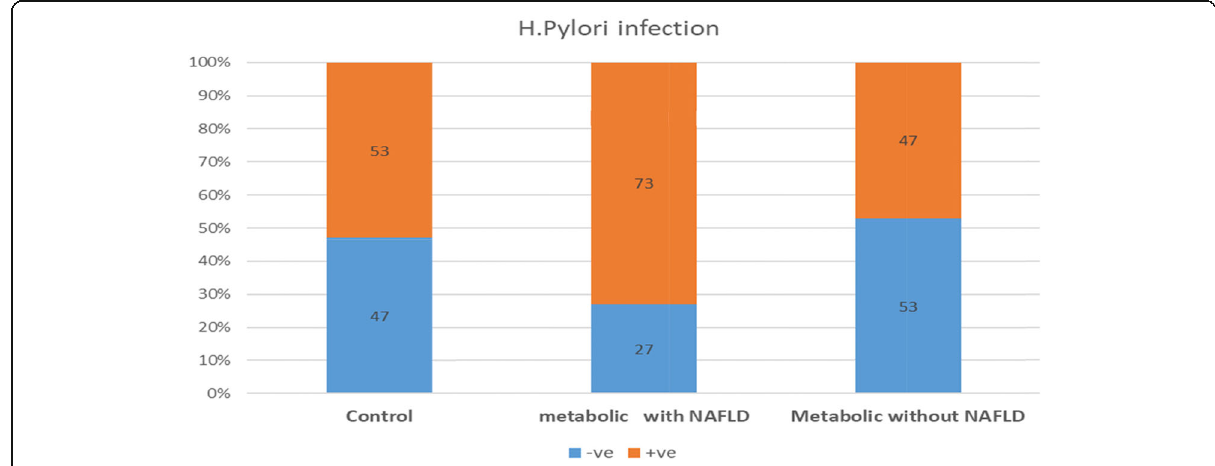
Fig. 1 Prevalence of HP infection in different study